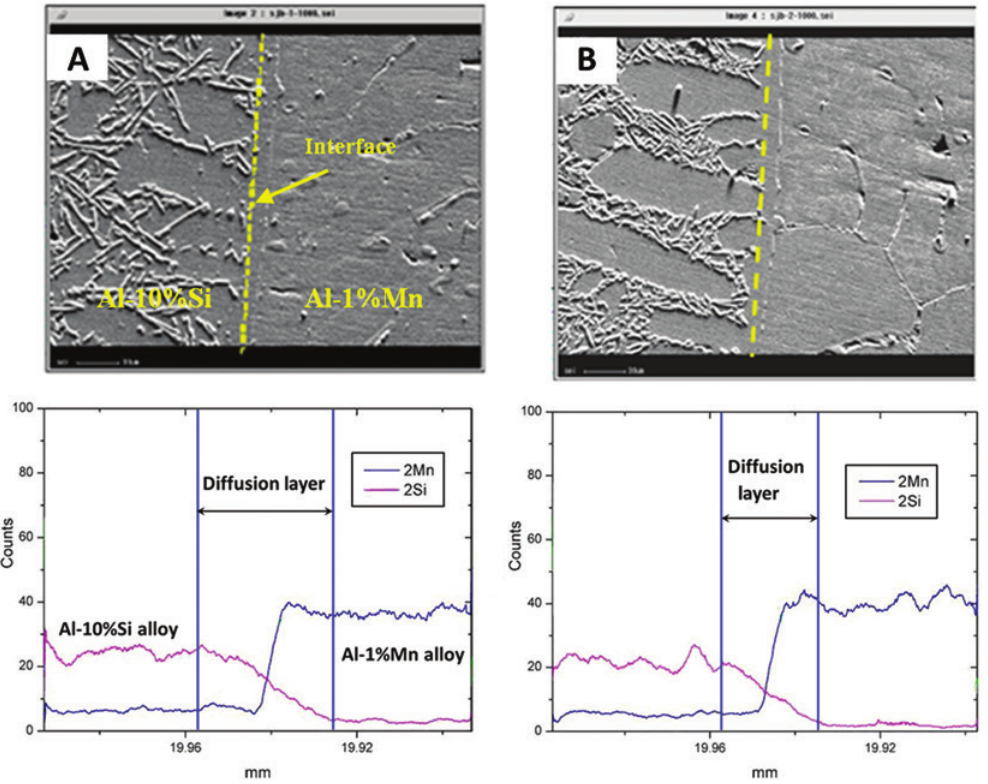
Figure 7: The content variations of Mn and Si at the diffusion layer of clad slab with different casting speeds: (A) 70 mm·min -1 and (B) 80 mm·min -1 .